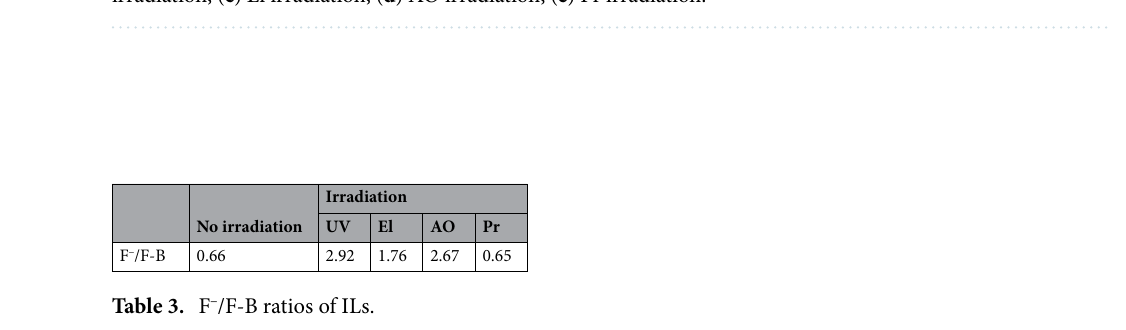
Figure 9. F 1 s peak in the XPS spectra for ILs before and after irradiation. ( a ) ILs (none irradiation), ( b ) UV irradiation, ( c ) El irradiation, ( d ) AO irradiation, ( e ) Pr irradiation.